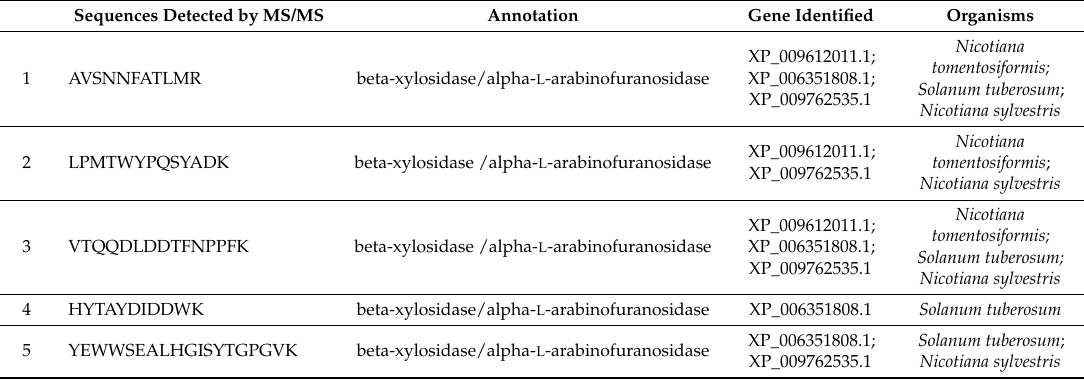
Table 2. Fragment sequences of the B. calycina β -glycosidase detected by tandem mass spectrometry (MS/MS) and their identical hits from other plant species.